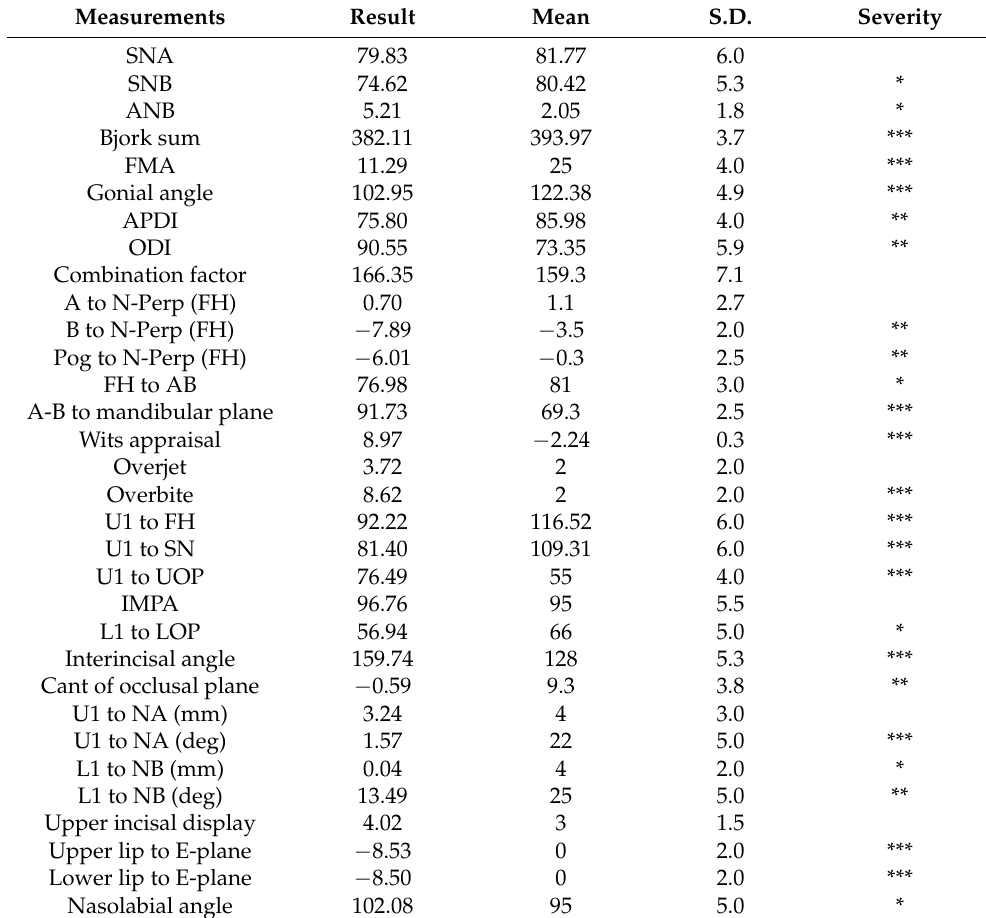
Table 1. Pre-treatment cephalometric values of case number 1.